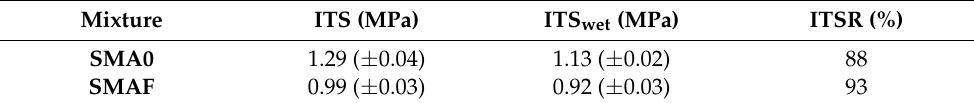
Table 9. Average ITSR results.